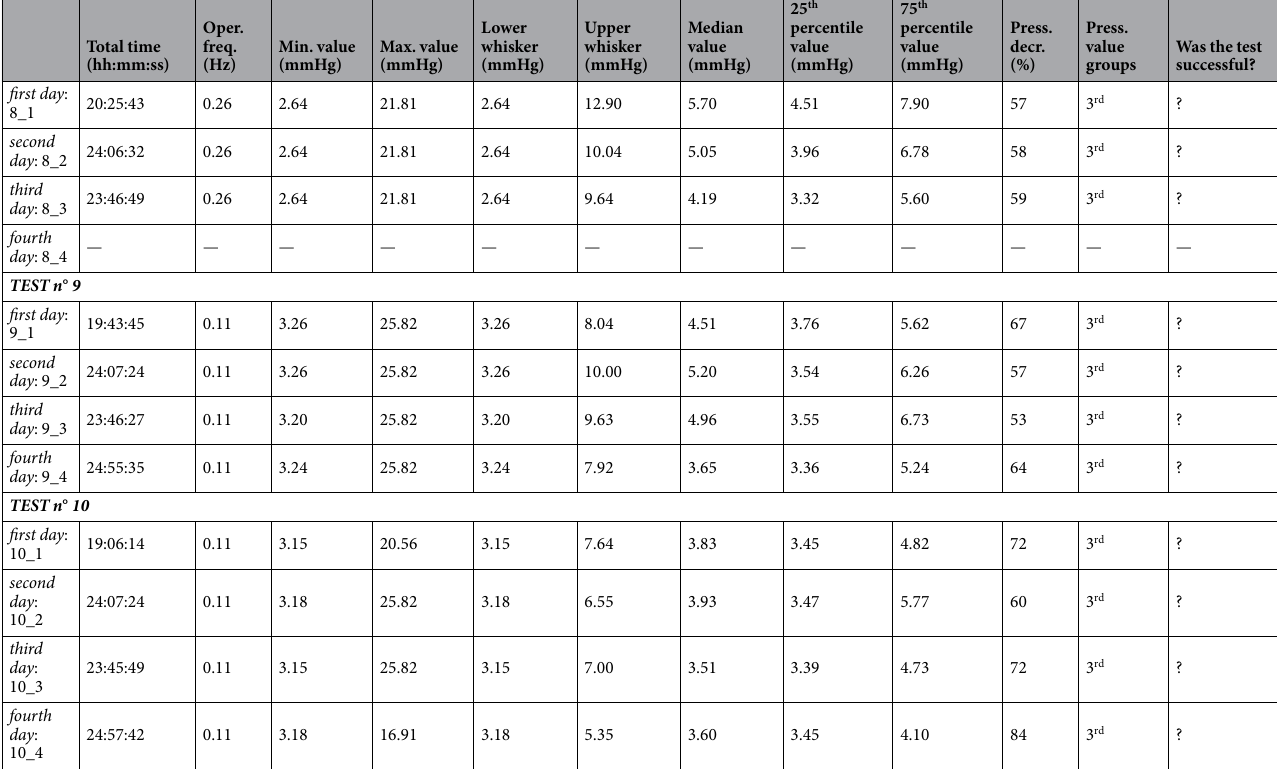
Table 2. Results of the electro-pneumatic device’s performance during the prospective study with animals.